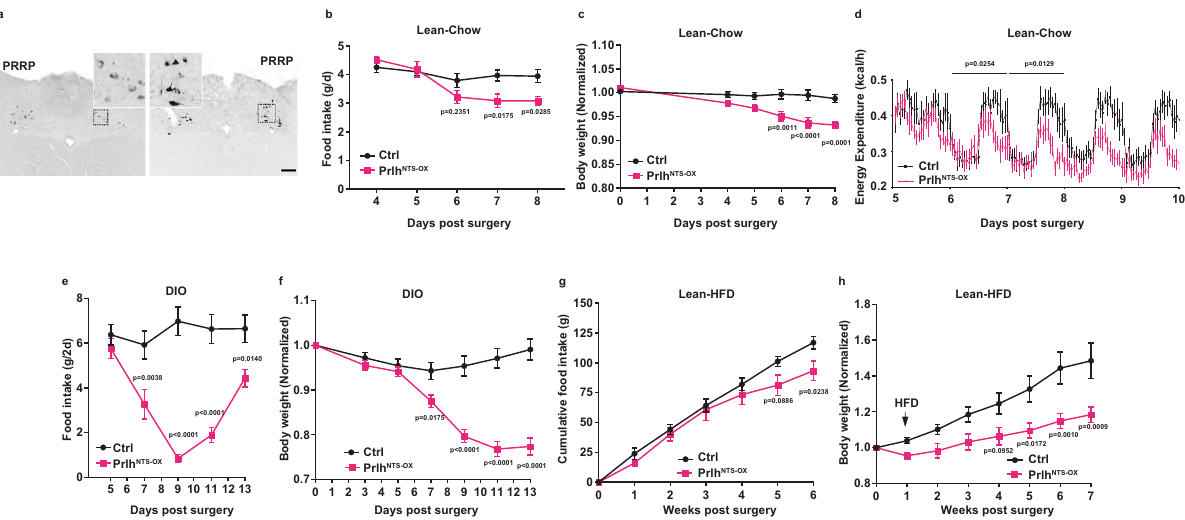
Fig. 4 Increased Prlh expression in Prlh NTS neurons promotes negative energy balance. A Representative images of PRRP-IR (black) in the NTS of control (Ctrl, left panel) or Prlh NTS-OX mice (right panel). All images were captured at the same magni fi cation; scale bar equals 150 µ m. Insets show digital zooms of the boxed regions. B , C Food intake ( B ) and body weight ( C ) for lean, chow-fed control (Ctrl) and Prlh NTS-OX mice following surgery ( n = 5 Ctrl animals and n = 6 Prlh NTS-OX animals); body weight is shown normalized to baseline (pre-surgery) weight. D Energy expenditure for chow-fed control (Ctrl) and Prlh NTS-OX mice was determined in metabolic cages for days 5 – 9 following surgery ( n = 8 per group). E – H Food intake ( E , G ) and body weight ( F , H ) for control (Ctrl) and Prlh NTS-OX mice following surgery in ( E , F ) DIO ( n = 6 Ctrl animals and n = 7 Prlh NTS-OX animals), and ( G , n = 8 Ctrl animals and n = 5 Prlh NTS-OX animals, H , n = 10 animals/group) chow-fed mice switched to HFD 7 days post-surgery ( n = 5 – 10 per group). Body weight is shown normalized to baseline (pre-surgery) weight. Shown is mean + / − SEM. Two-way ANOVA, sidak ’ s multiple comparisons test was used; p values are shown for signi fi cant comparisons. All experiments were repeated in two independent cohorts of animals with similar results; cohorts were combined for